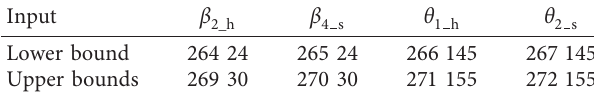
Table 9: Efficiency under three